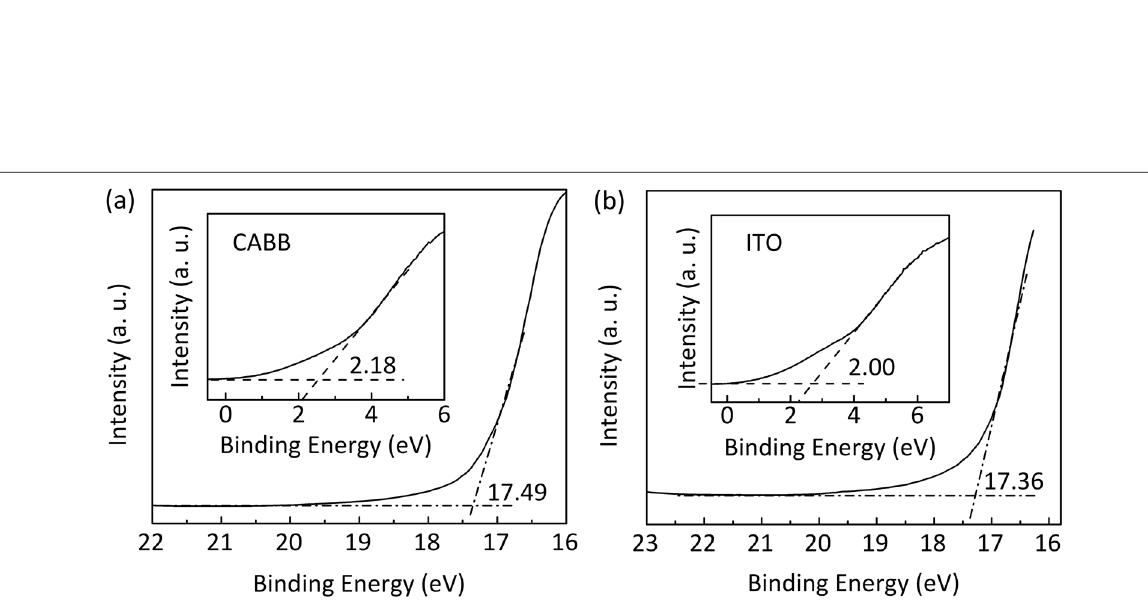
Fig. 7 a UPS spectrum of the CABB film at cutoff region obtained with h ν = 21.22 eV. The inset depicts the Fermi edge of CABB. b Cutoff region of the ITO-coated glass. The inset displays the Fermi edge of the ITO